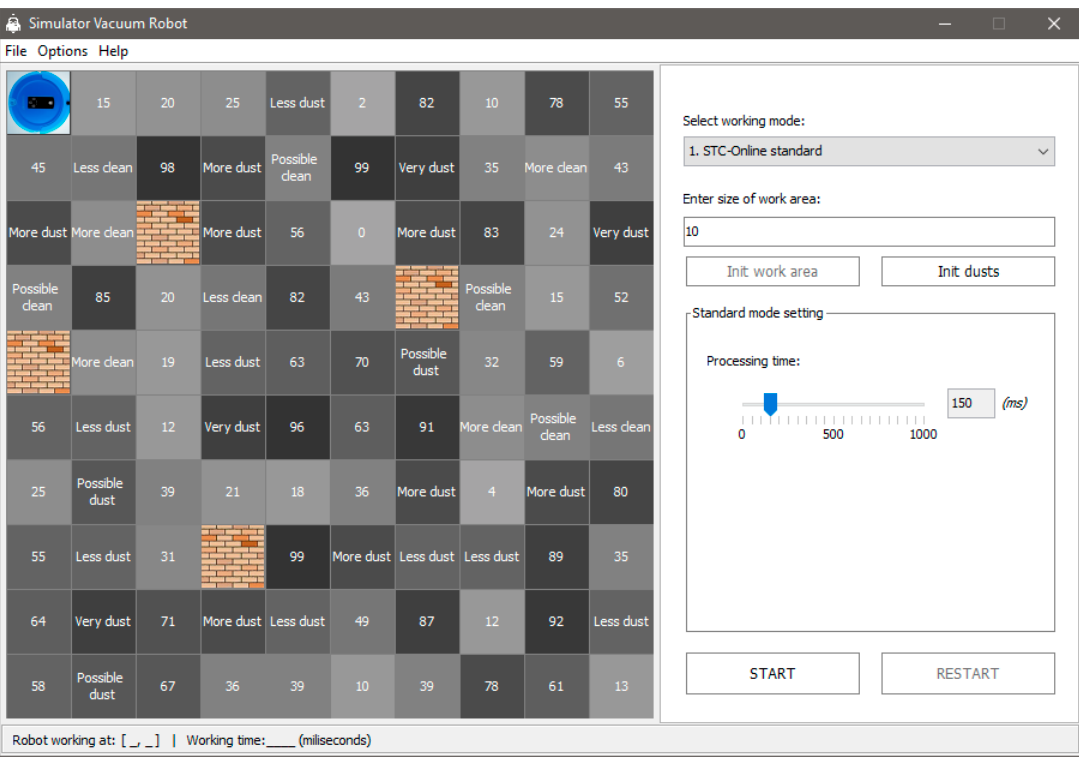
Figure 5. The interface for the experimental robot setting (the operating environment).